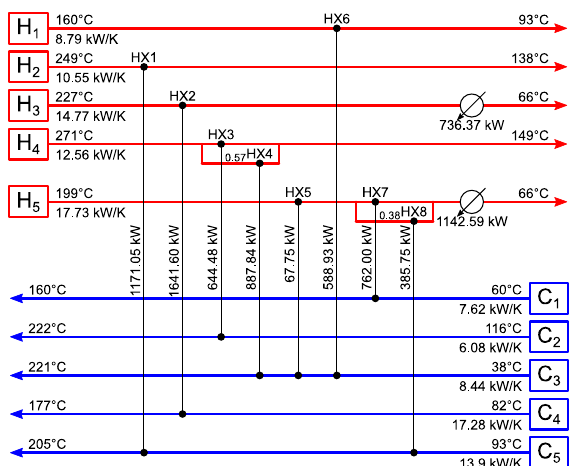
Table 2. Results comparison for example 1a.